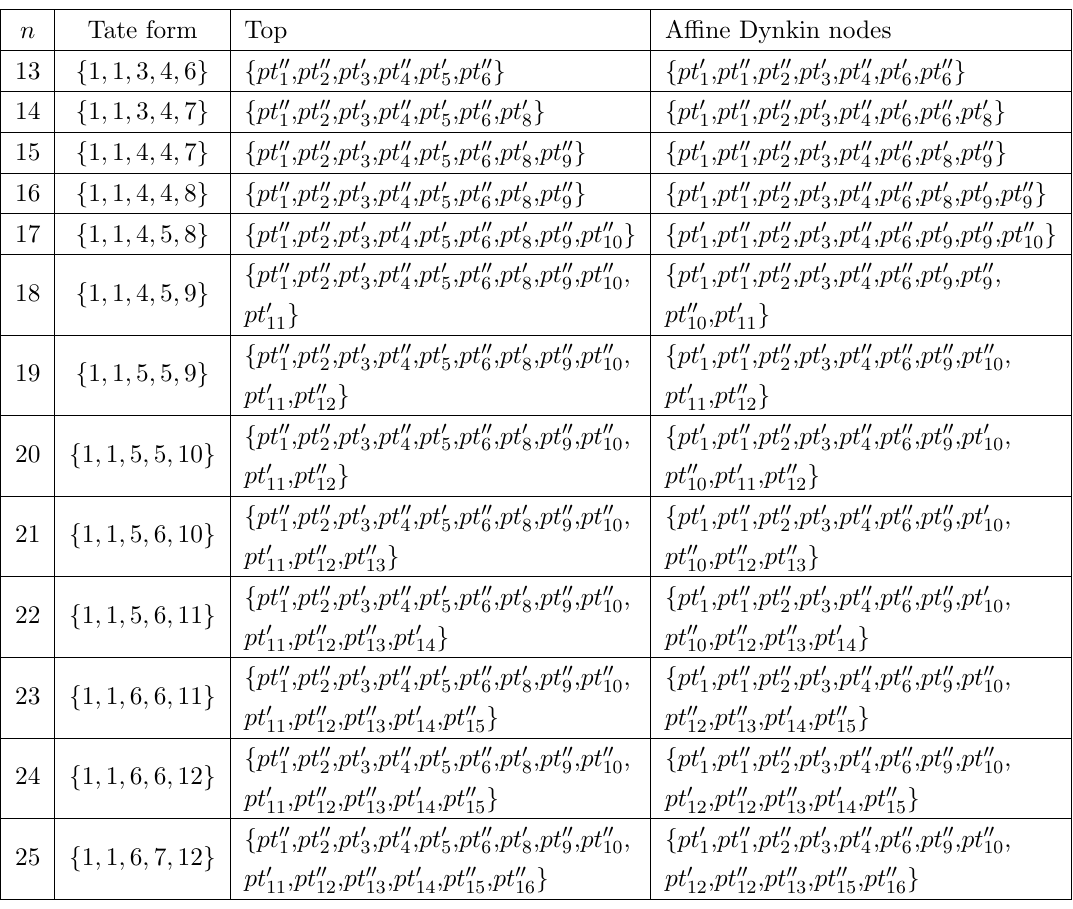
Table 8. The tops of so ( n ) algebras. The coordinates of the points pt 1 ; 2 ; 3 ; 4 ; 5 ; 6 ; 7 ; 8 ; 9 ; 10 ; 11 ; 12 ; 13 ; 14 ; 15 ; 16 are given in equations (4.4) and (4.5). (Only the highest level point for each pt is listed in each top, and the lattice points of the lower levels are implied.) so (4 n (cid:0) 1) and so (4 n ) in the table have the same top but di(cid:11)erent (numbers of) a(cid:14)ne Dynkin nodes as the ranks (which di(cid:11)er from the number of the nodes by one) are di(cid:11)erent. These tops match those found in [22] after an appropriate coordinate